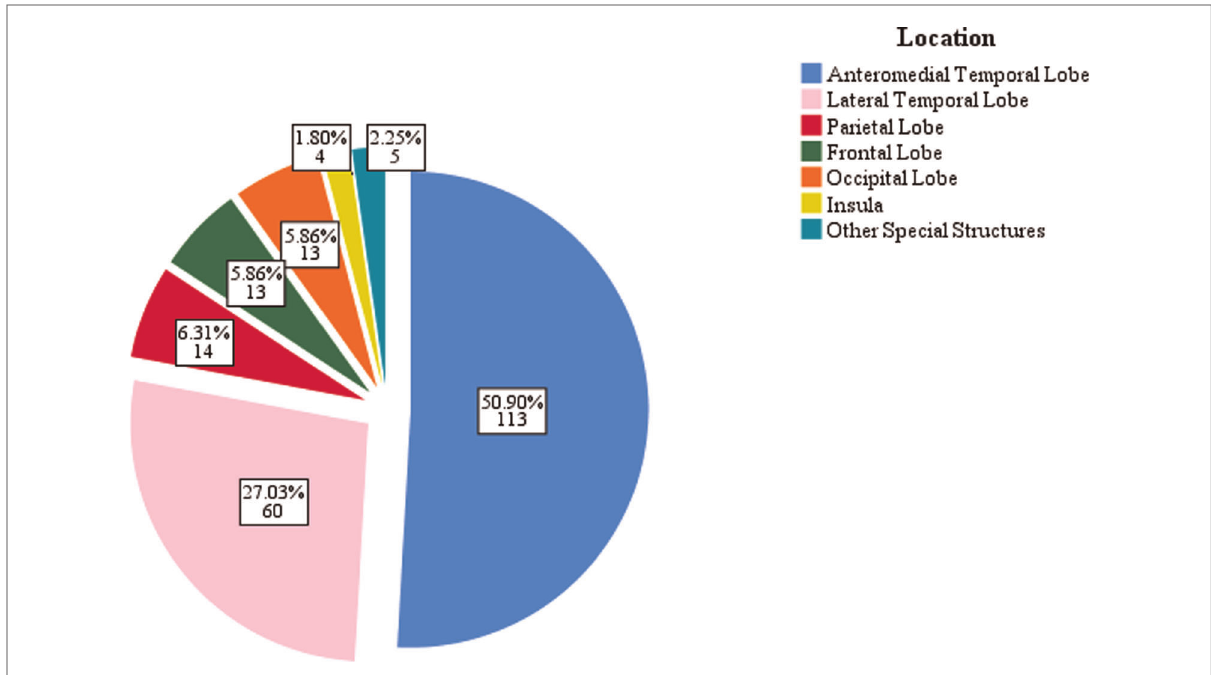
FIGURE 2 The location distribution of GG.